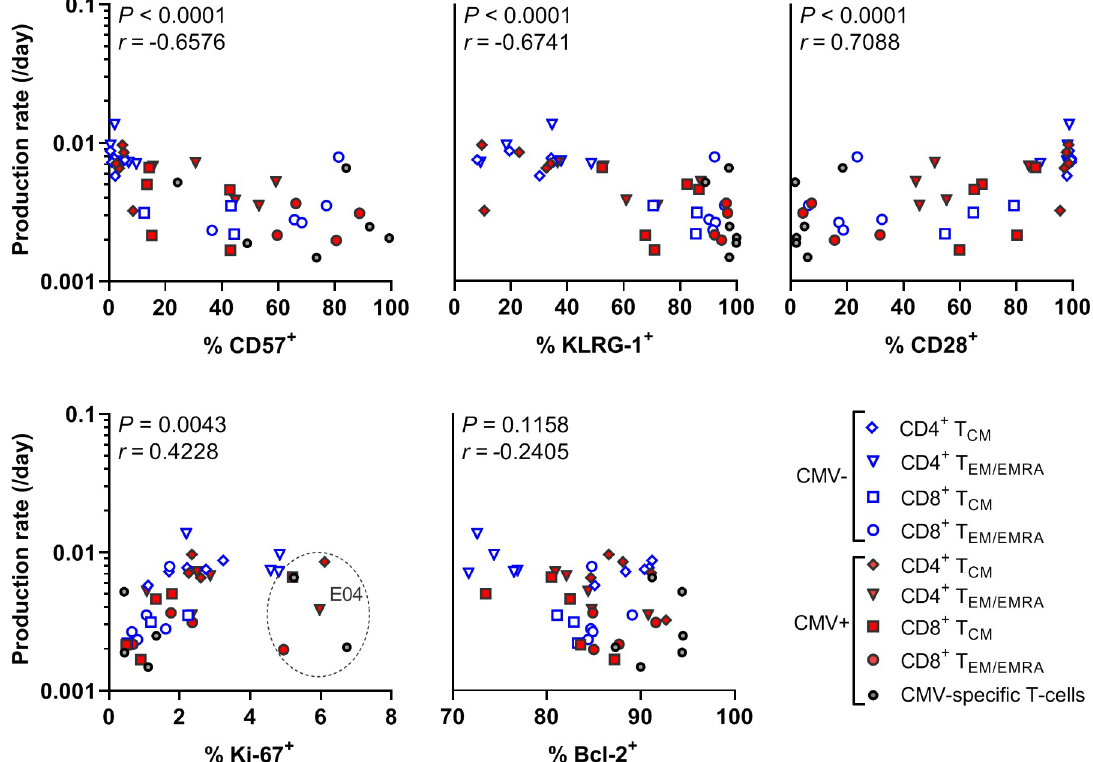
Fig 5. Association between T-cell production rates and expression of senescence, proliferation, and apoptosis markers. The estimated average production rates of different CD4 + and CD8 + T-cell subsets as estimated by heavy water labelling were plotted against their expression (% positive) of CD57, KLRG-1, CD28, Ki-67, and Bcl-2. Data points of donor E04 are circled in the Ki-67 graph. Correlation was tested by Spearman’s correlation, P- values and r -values are indicated in the graphs. Different symbols represent different memory